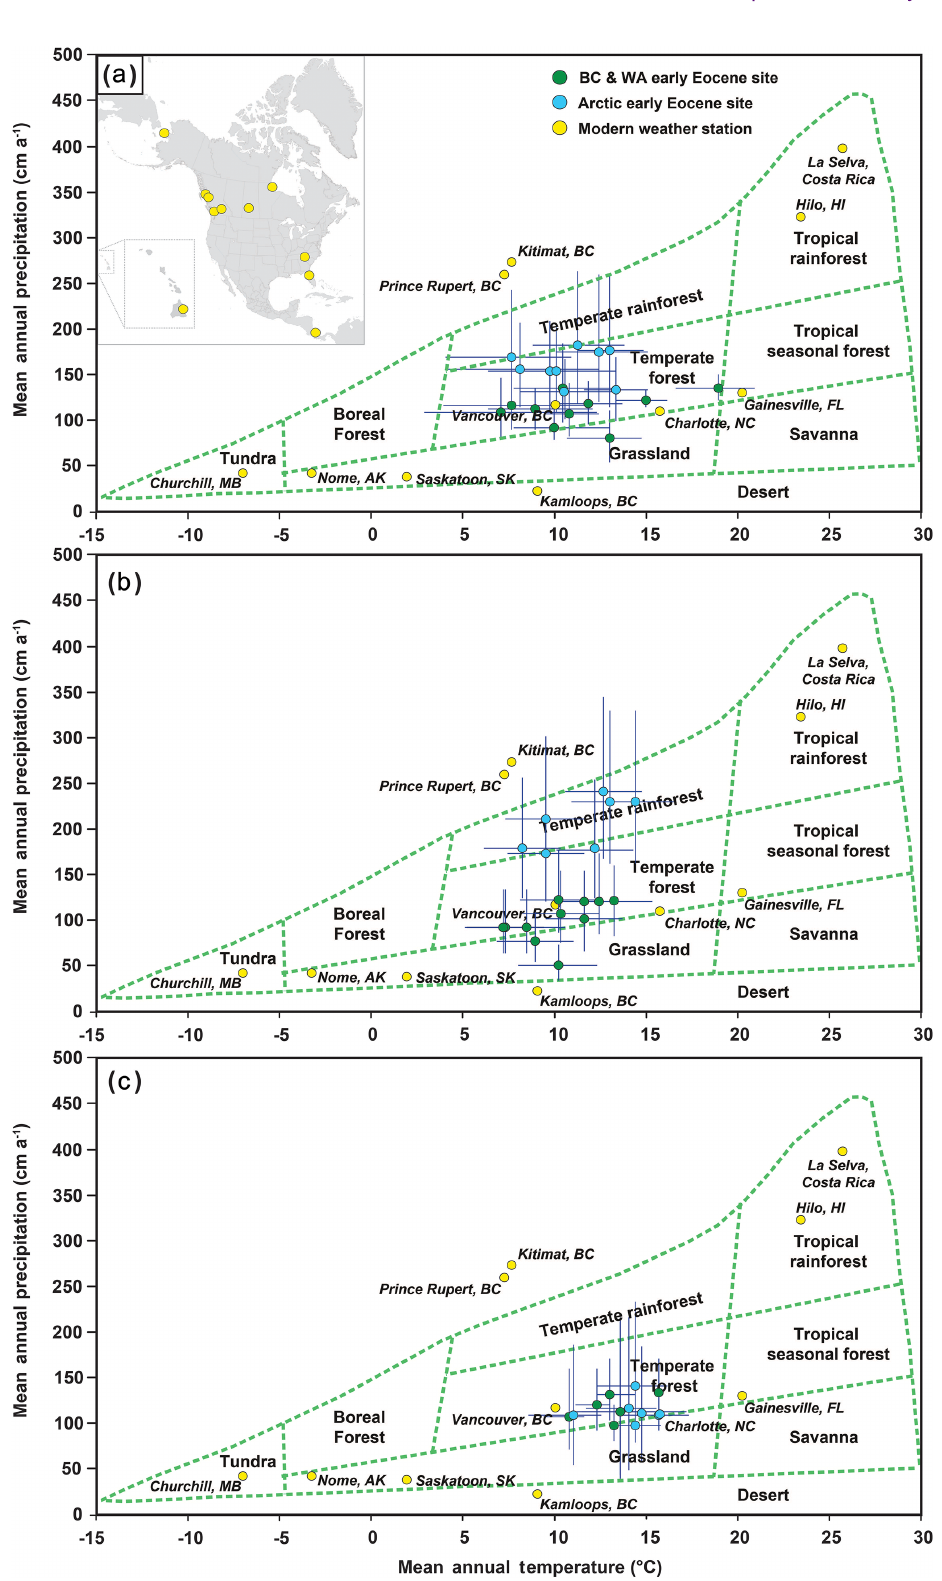
Figure 3. Biome charts showing the paleoclimate data plotted against modern climate parameters defining modern biomes. (a) Ensemble climate estimates including an inset map of North America showing the locations of modern weather stations, (b) leaf physiognomy estimates, and (c) BA